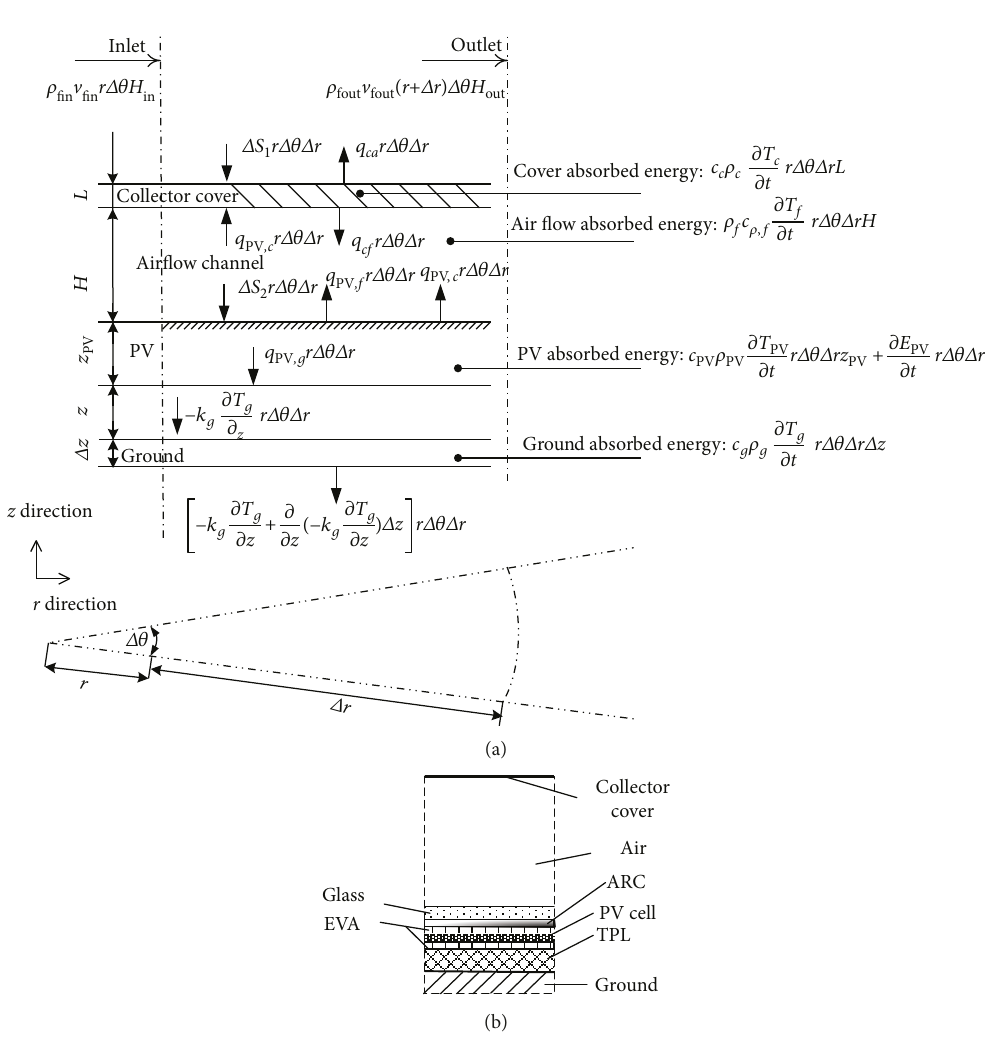
Figure 2: Energy balance of a representative elemental volume in the solar collector and PV: (a) full view and (b) enlarged view of the PVT